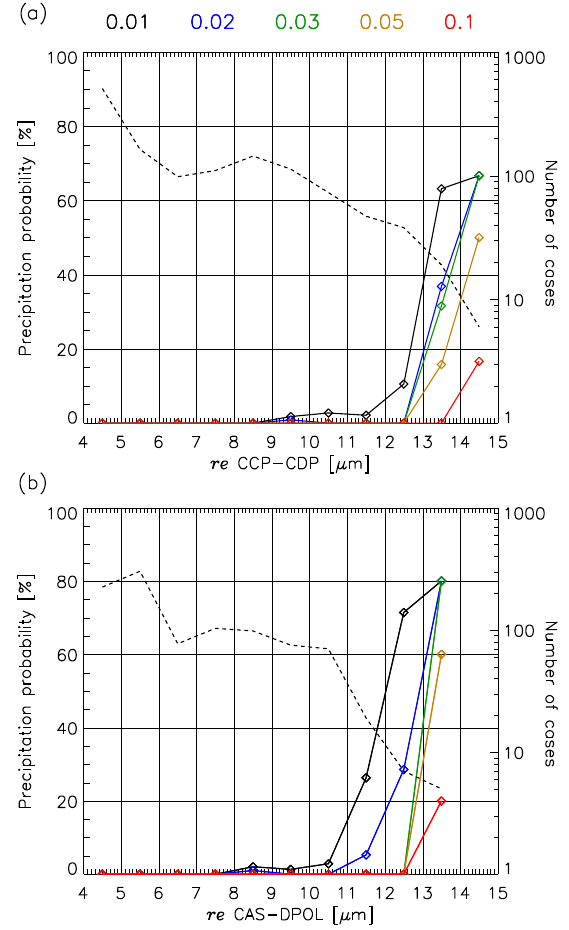
Figure 2. (a) Precipitation probability as a function of r e for the CCP–CDP probe for different DWC thresh- olds (black DWC>0.01gm − 3 ; blue DWC>0.02gm − 3 ; green DWC>0.03gm − 3 ; gold DWC>0.05gm − 3 ; red DWC>0.1gm − 3 ) . The dashed line indicates the number of cases (in seconds for each 1s cloud pass) for each r e size interval (right axis); (b) similar for the CAS-DPOL